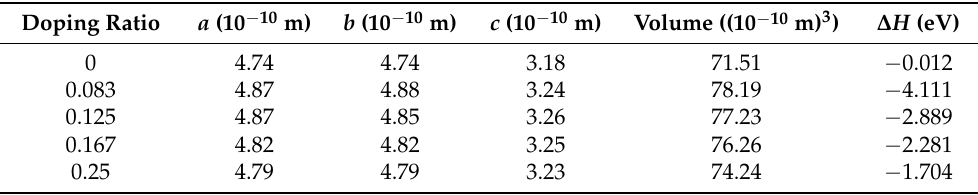
Table 3. Lattice constant, volume and enthalpy